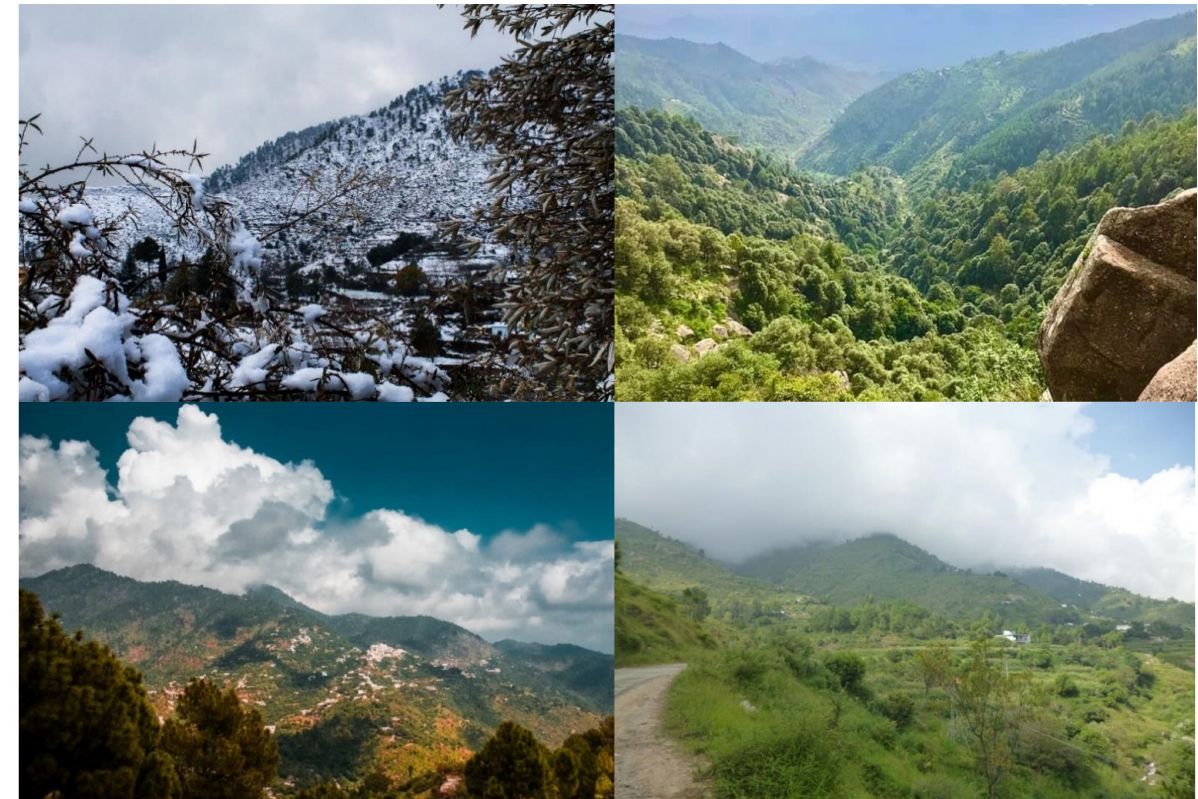
Figure 2. Landscapes of the study area in different